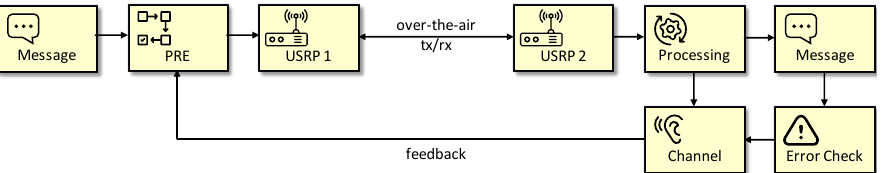
Figure 12. Block diagram of the ping-pong application with integrated waveform development toolbox. Two radios alternate transmitting and receiving a message while simultaneously performing channel measurements and spectral sensing. A protocol recommendation engine automatically optimizes the waveform and frequency allocation to adapt to changes in received SNR, spectral opportunities, and channel impairments. WISCANet allows users to test these kinds of PHY and MAC layer techniques without having to design a network themselves, thereby reducing the barrier to entry and allowing users to focus on research rather than the tedium of networking and